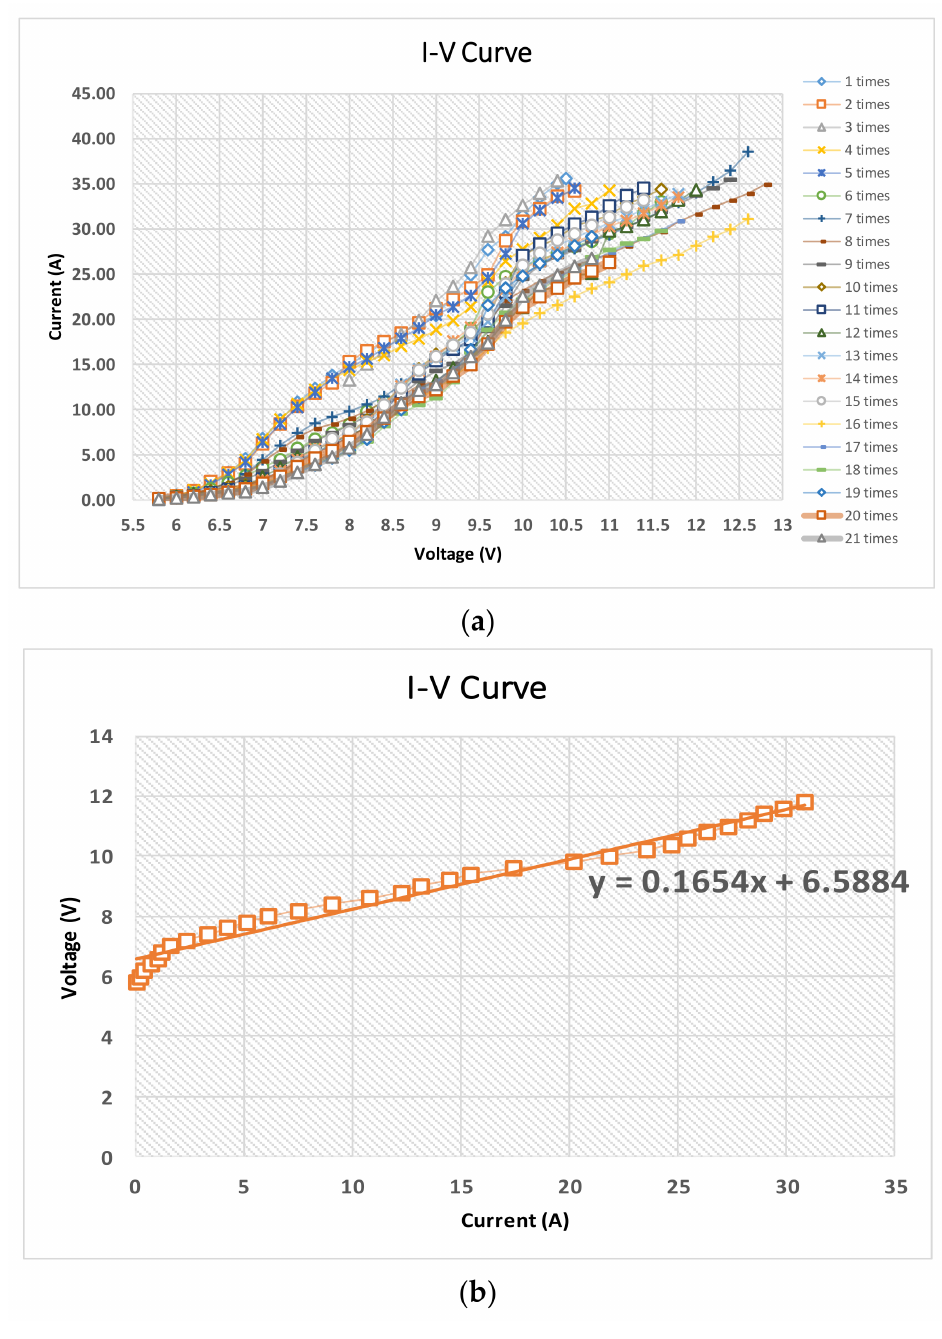
Figure 8. I–V characteristic curve of water electrolyzer: ( a ) the whole experiment, ( b ) a specific operating